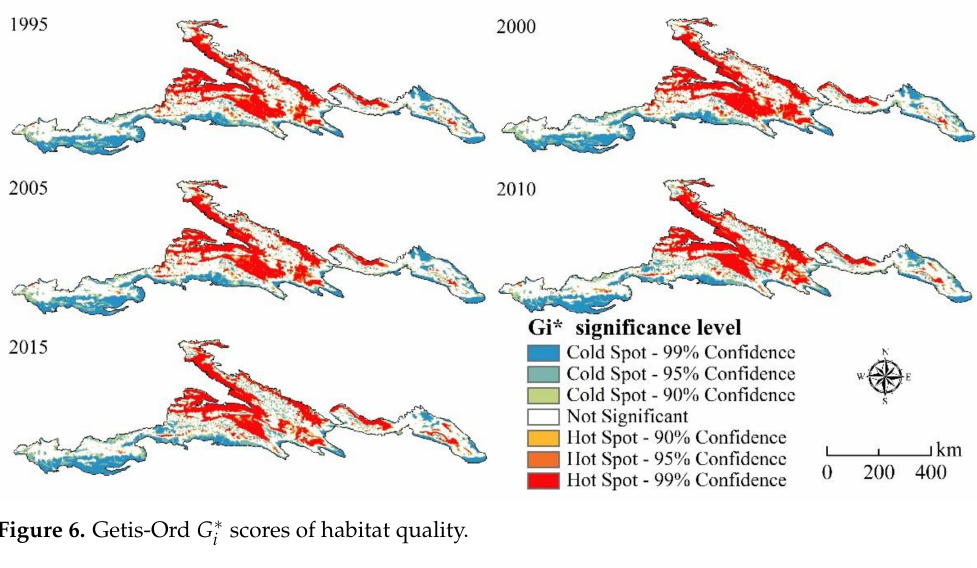
Figure 6. Getis-Ord G ∗